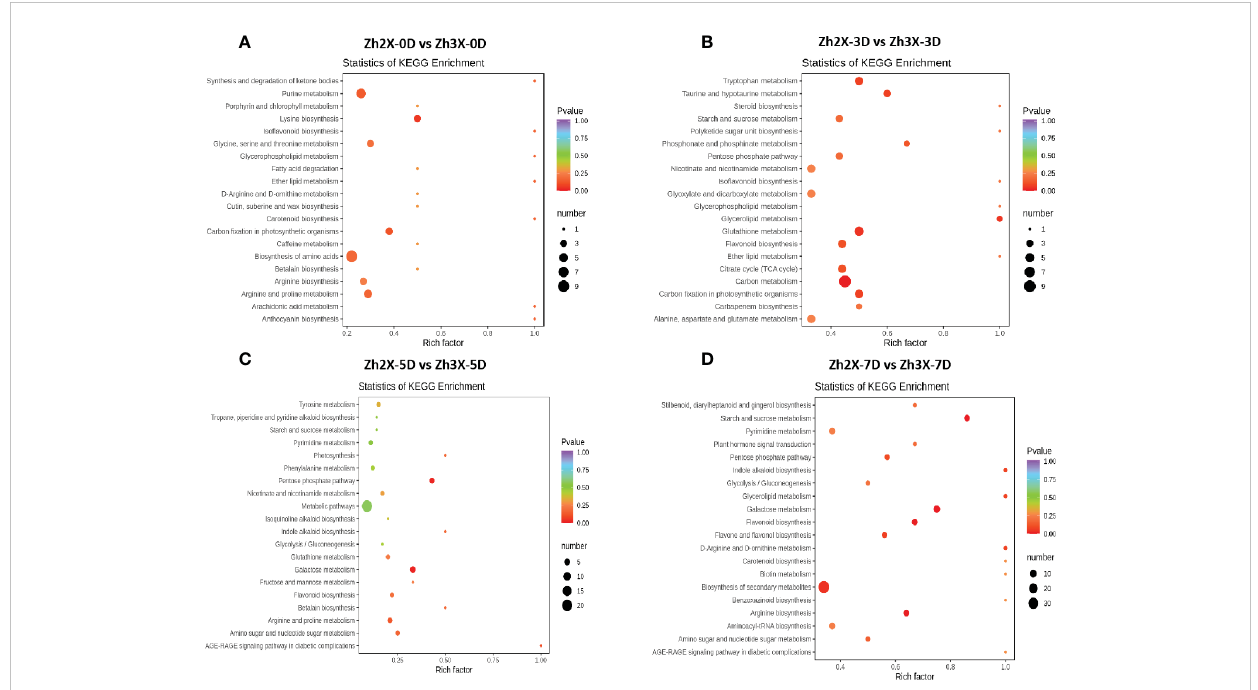
FIGURE 8 KEGG enrichment of detected metabolites. (A) Zh2X-0D vs Zh3X-0D, (B) Zh2X-3D vs Zh3X-3D (C) Zh2X-5D vs Zh3X-5D and (D) Zh2X-7D vs